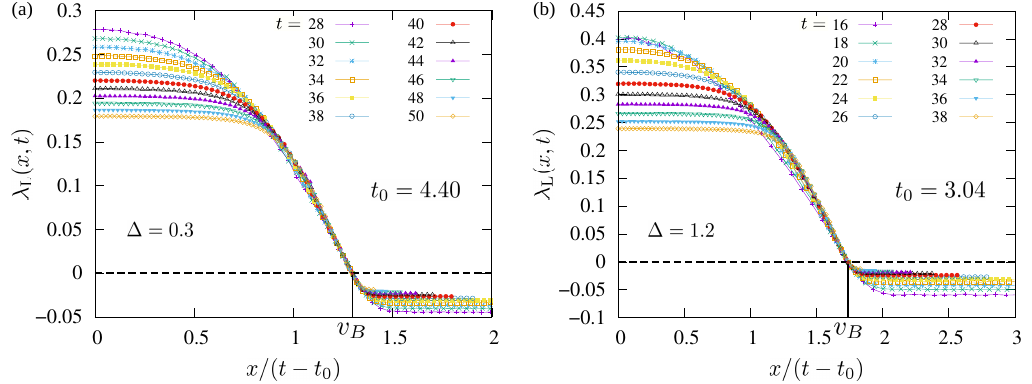
( x , t ) for differ- L ( x , t ) = 0) when plotted as L